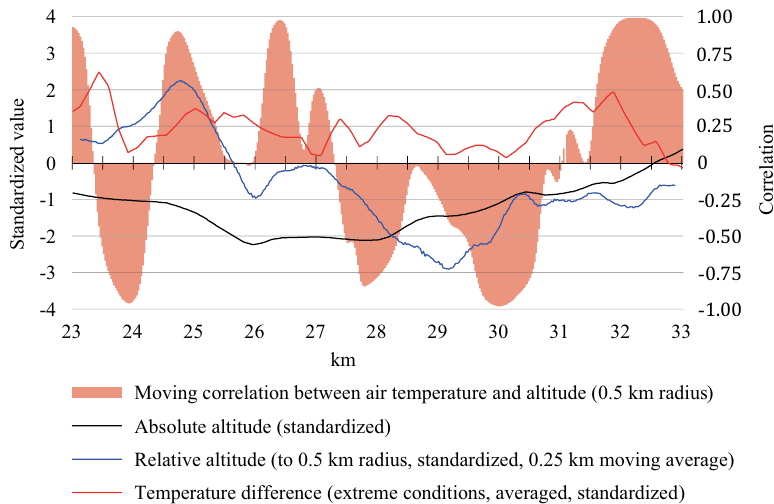
Moving correlation between air temperature and altitude (0.5 km radius) Absolute altitude (standardized) Relative altitude (to 0.5 km radius, standardized, 0.25 km moving average) Temperature difference (extreme conditions, averaged, Figure 1. An example of a set of parameters in a route in the Czech Republic